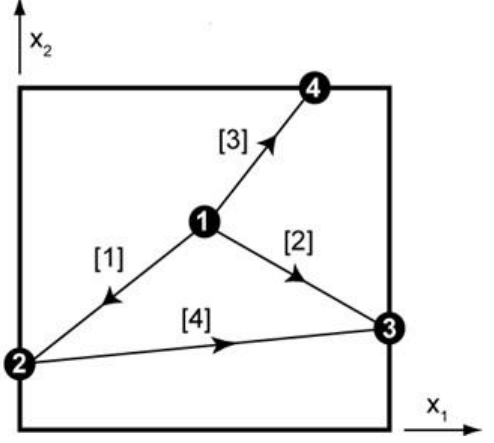
Figure 2. Example of a simple 2D fracture network, represented by a directed graph (“digraph”). Black circles such as represent the vertices of the graph (i.e., the nodes of the intersecting fracture network), and the line segments with numbers [2] represent the “arcs” or “edges” of the graph (i.e., the fracture segments or links between nodes). The links [ ℓ ] are interconnected to each other via vertices (nodes). The vertices can be numbered in any order, and similarly for the edge numbers. For a fracture network, the edge directions can also be set up using any predefined convention (see text).